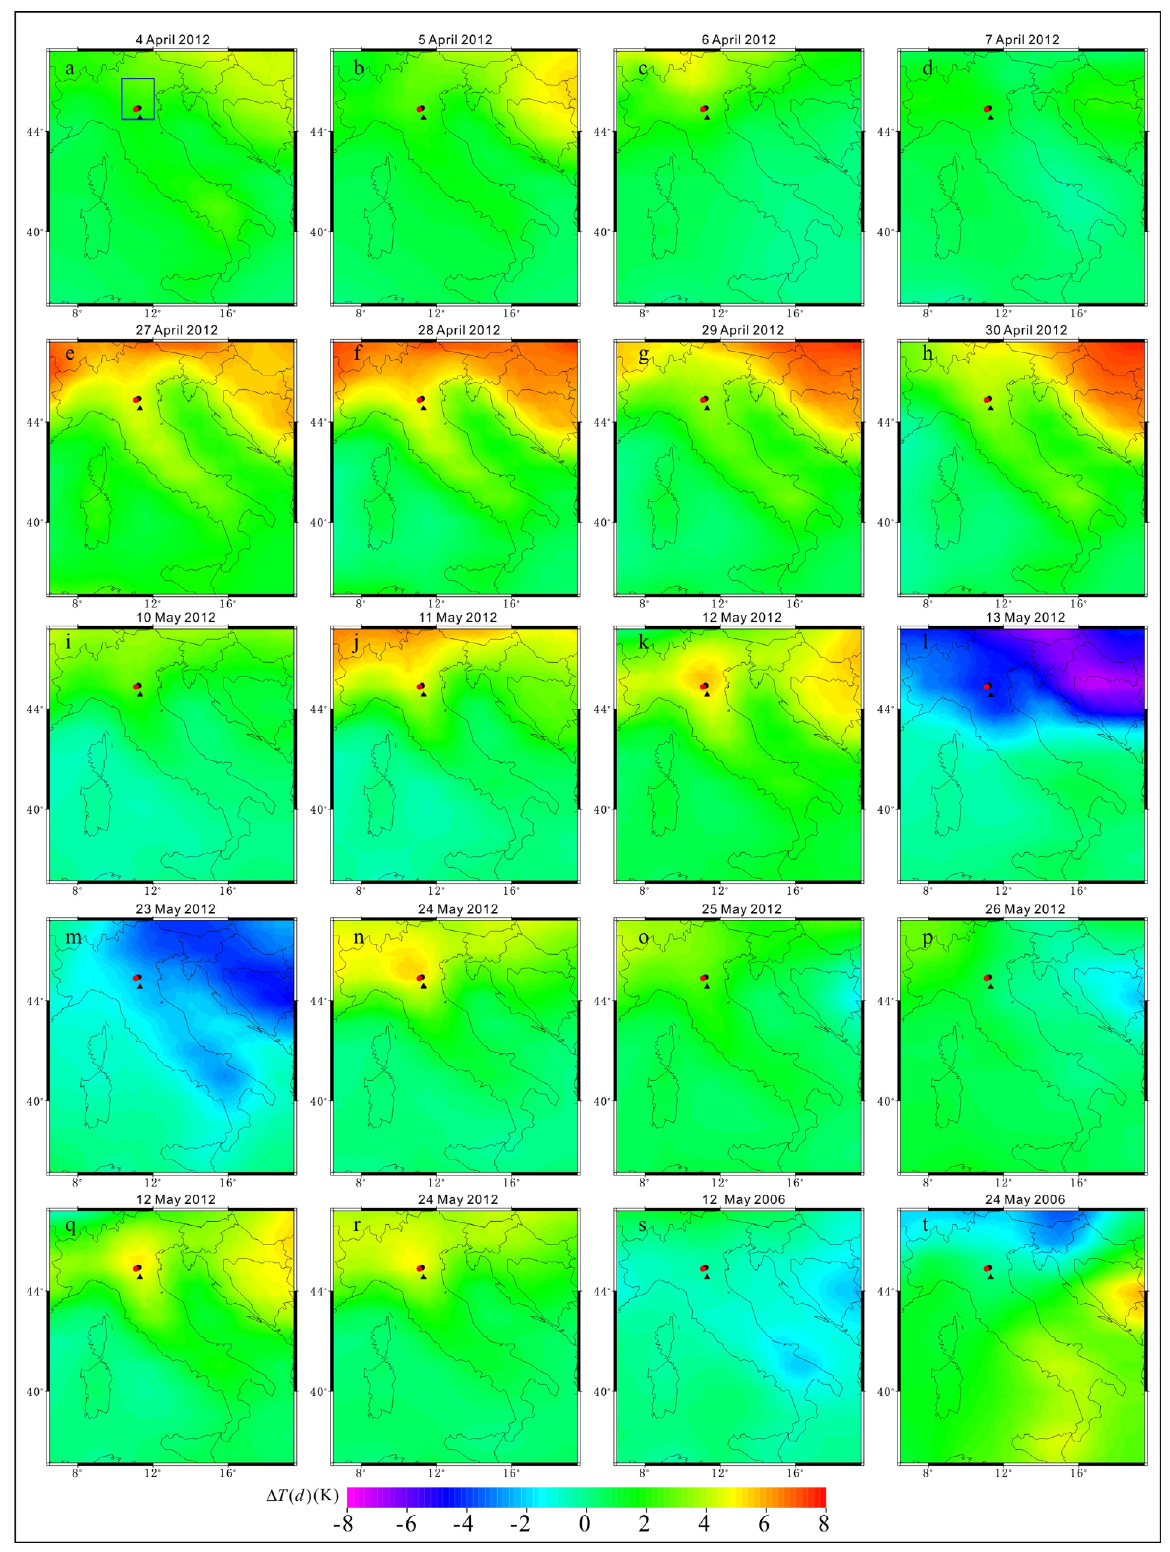
Figure 2. The spatial distributions of the changes in the daily temperature ( D T ( d )): a-h are obtained by subtracting the 33-year (1979-2011) mean of monthly temperature in April from the daily temperature ( T ( d )) on April 4-7 and 27-30, 2012, respectively; i-p are obtained by subtracting the 33-year (1979- 2011) mean of monthly temperature in May from the T ( d ) on May 10-13 and 23-26, 2012, respectively; q is obtained by subtracting the 20-year (1992-2011) mean of the monthly temperature in May from the T ( d ) on May 12, 2012; r is obtained by subtracting the 20-year (1992-2011) mean of the monthly tem- peratures in May from the T ( d ) on May 24, 2012; s is obtained by subtracting the 33-year (1979-2011) mean of the monthly temperatures in May from the T ( d ) on May 12 2006; t is obtained by subtracting the 33-year (1979-2011) mean of monthly temperature in May from the T ( d ) on May 24 2006. The black and red points indicate the epicenters on May 20 and 29, 2012, respectively. The black triangles indicate the weather ground station of Bologna (44.53 ˚N, 11.3 ˚E), close to the epicenters. The blue rectangular box in a indicates the area around the two major earthquakes epicenters (44.5 ˚N to 46 ˚N, 10.5 ˚E to 12 ˚E) for the time series